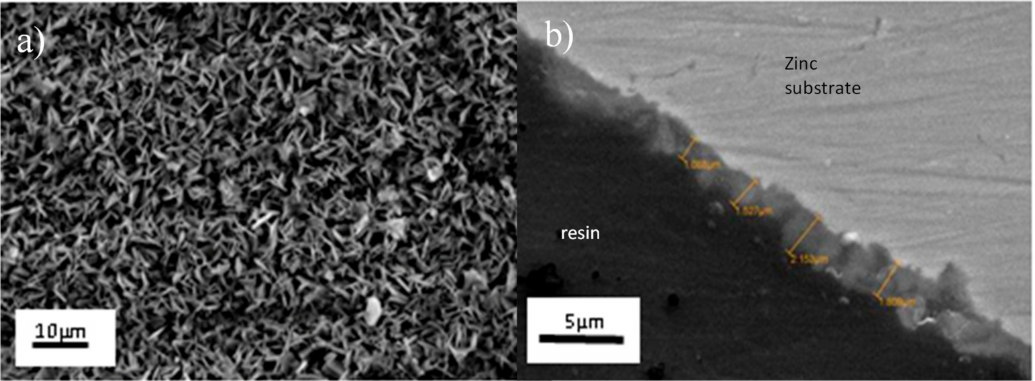
Figure 2. Scanning electron micrographs of phosphated zinc of ( a ) surface, and ( b )